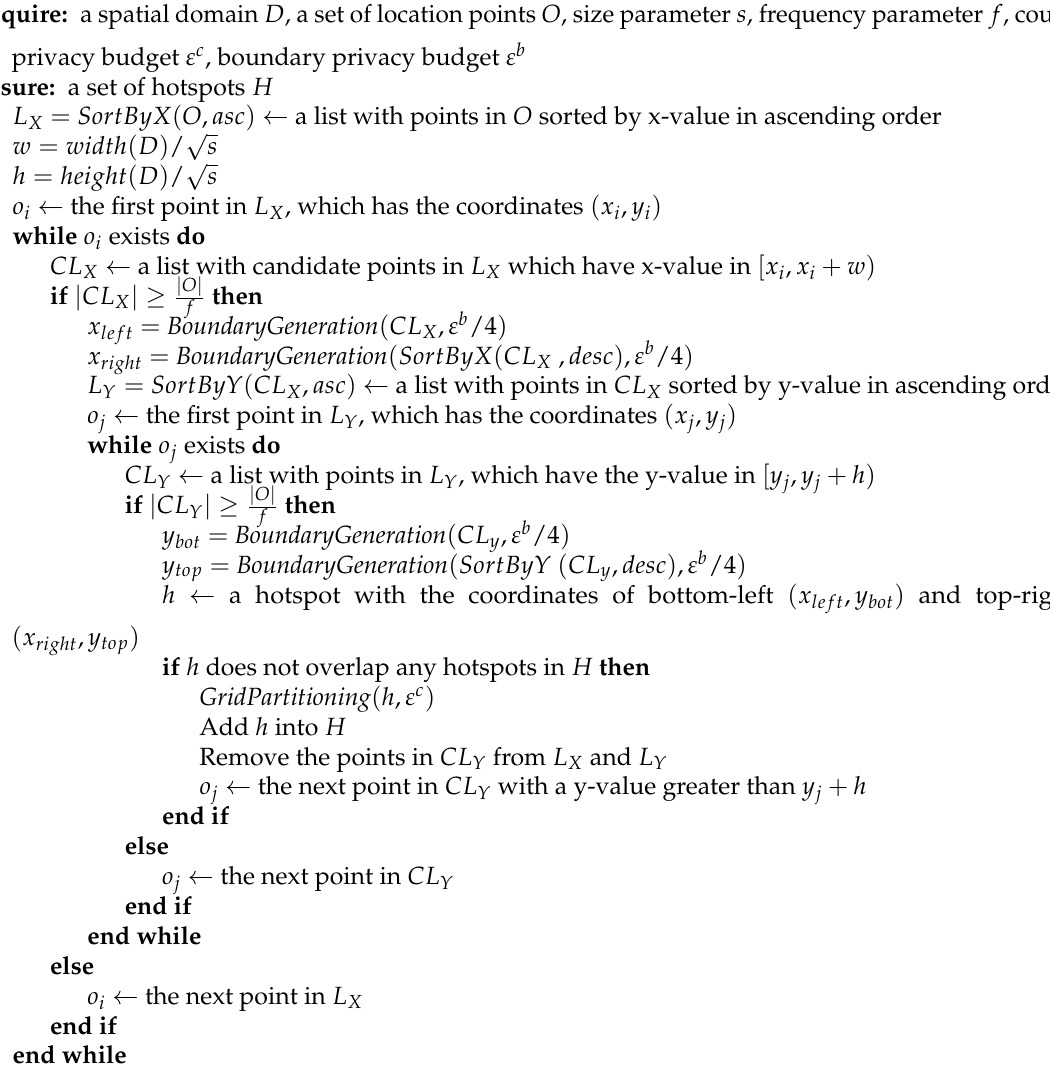
Algorithm 3 SAGA